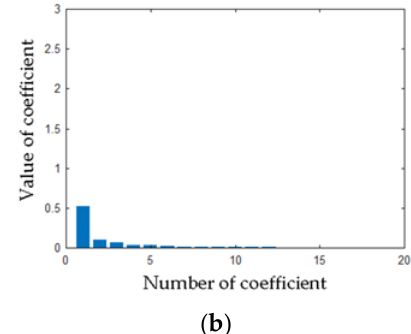
Figure 17. ( a ) Histogram of the matrix V for the thermal image of the healthy angle grinder ( b ) Values of PCA of the matrix V for the thermal image of the healthy angle grinder. Computed matrix V for the angle grinder with 1 blocked air inlet was presented in Figure 18. Histograms and PCA values for the angle grinder with 1 blocked air inlet were presented in Figure 19.